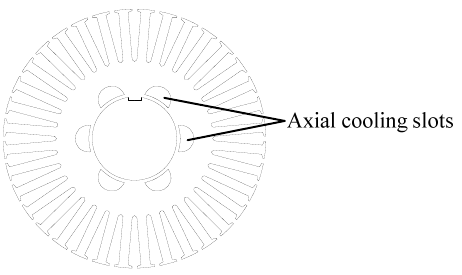
Figure 4. Schematic diagram of axial cooling